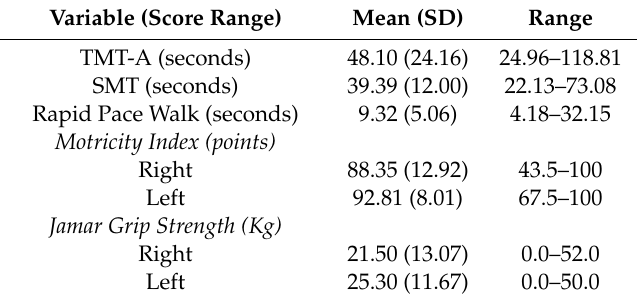
Table 4. Results of cognitive and motor testing of study